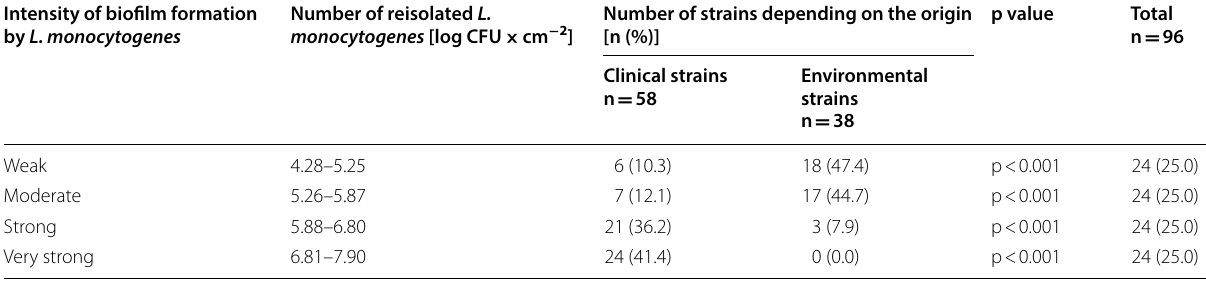
Italic values indicate significance of p value (p 0.05) ≤ a p value 0.05 ≤ Table 4 Classification of tested L. monocytogenes rods depending on the biofilm formation intensity based on the number of bacteria isolated from the steel surface in a quantitative method Intensity of biofilm formation by L. monocytogenes